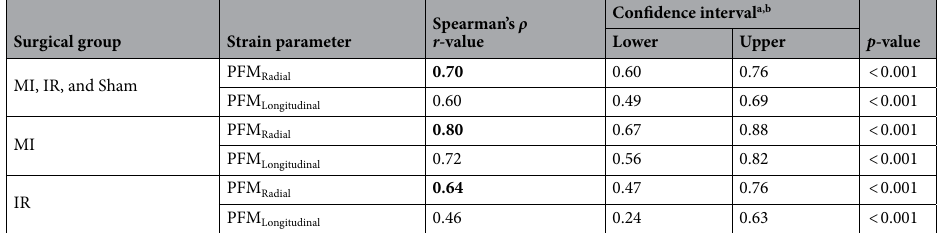
Table 1. Correlation of strain parameters against fibrotic myocardium measured with histopathology. a Estimation is based on Fisher’s r-to-z transformation. b Estimation of standard error is based on the formula proposed by Fieller, Hartley, and Pearson. Highest correlation values for each surgical group’s correlation analysis are shown in